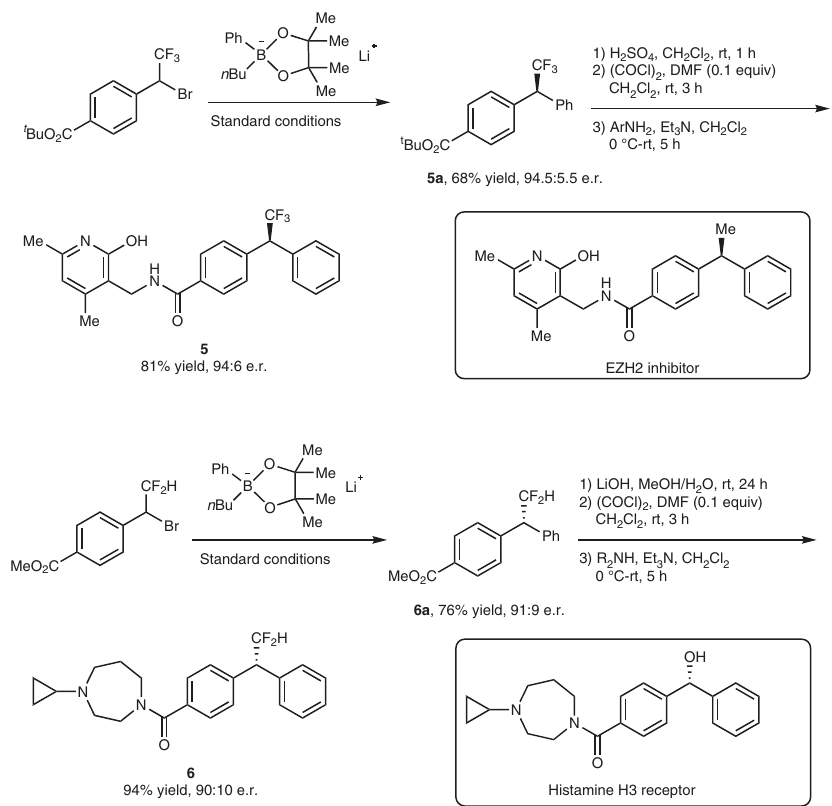
Fig. 7 Synthetic applications. Application in the preparation of fl uoroalkylated derivatives of drug